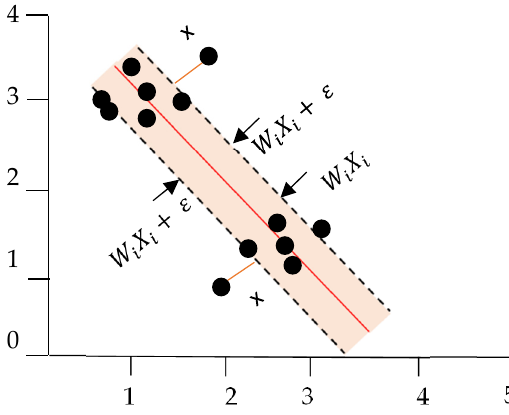
Figure 9. Support vector regression (typical form).